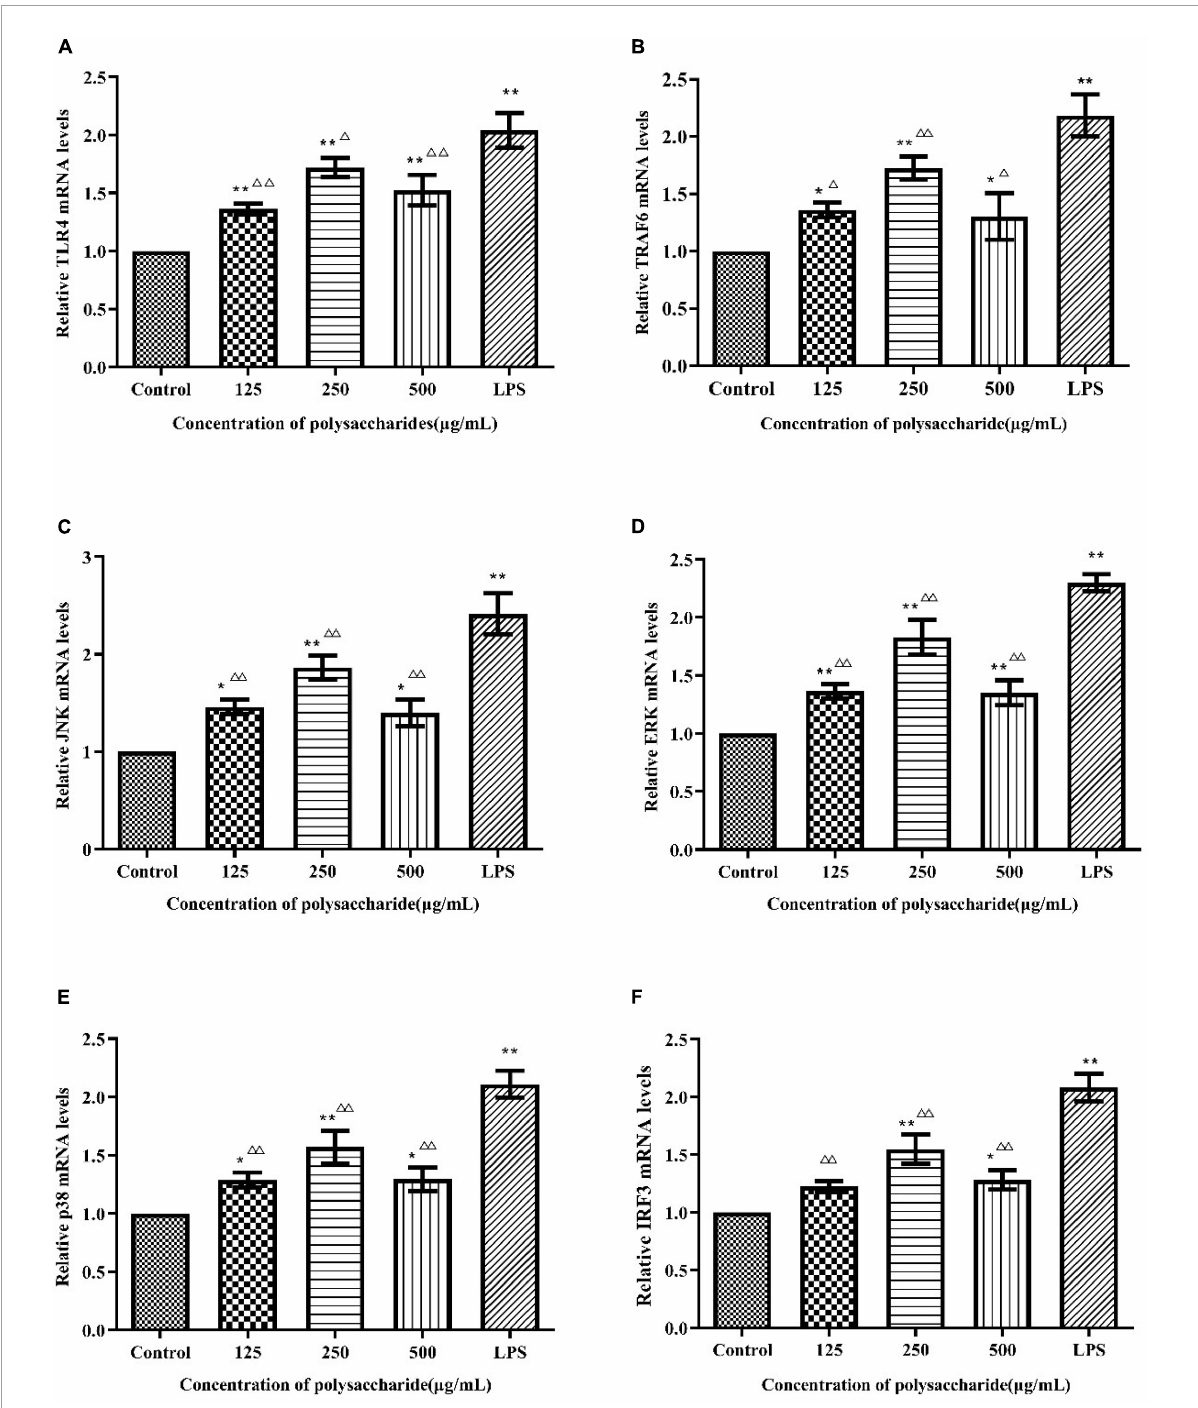
FIGURE8 Effects of Sparassis latifolia neutral polysaccharides SLNP on mRNA expression of TLR4 (A) , TRAF6 (B) , JNK (C) , ERK (D) , p38 (E) , and IRF3 (F) on RAW264.7 macrophage. Compared with blank control group, * p < 0.05, ** p < 0.01; Compared with LPS control group, (cid:49) p < 0.05 , (cid:49)(cid:49) p < 0.01.